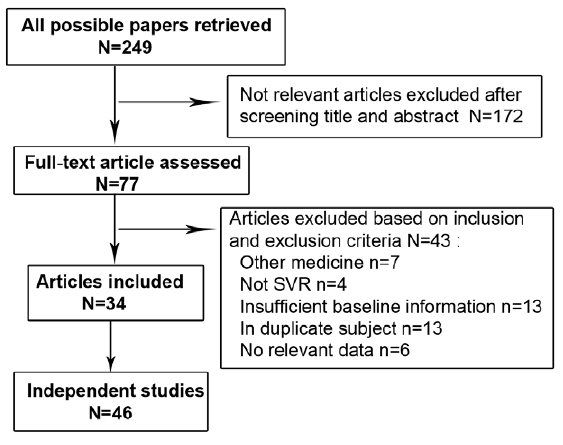
Figure 1. Flow chart summarizing the process of study